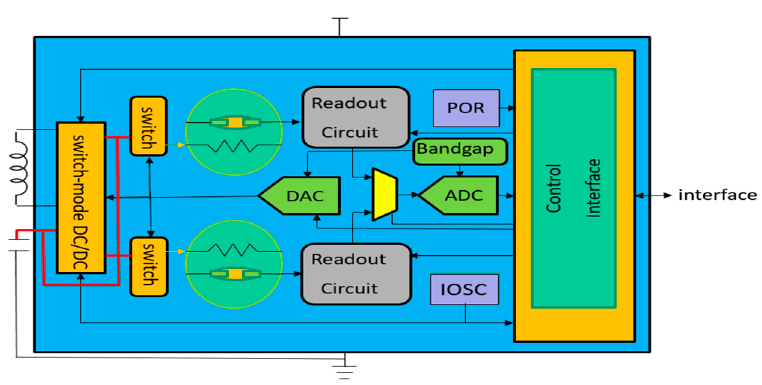
Figure 12. CMOS-MEMS base gas sensors function block.